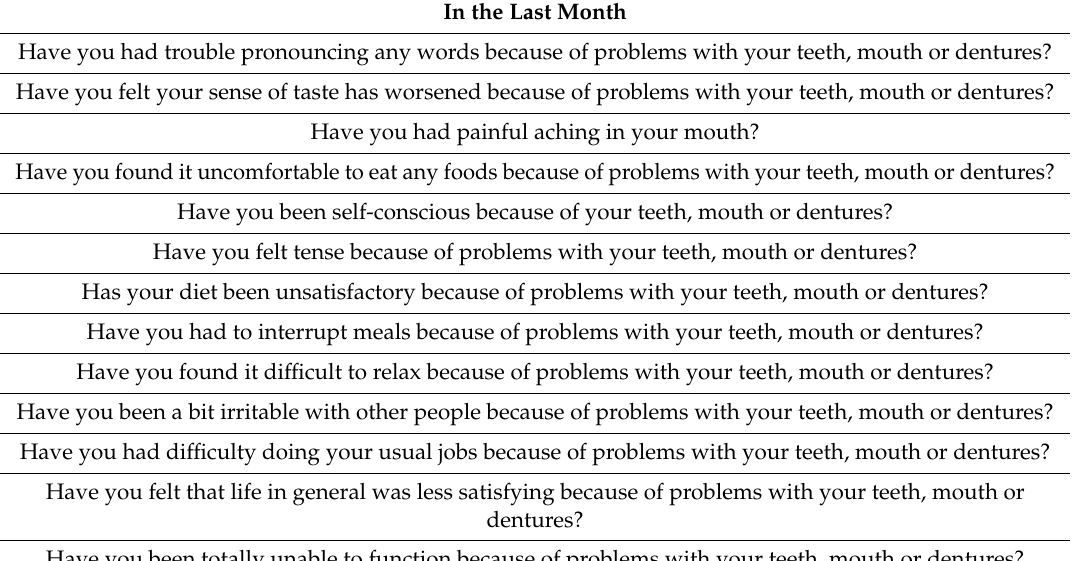
Table A1. OHIP-14